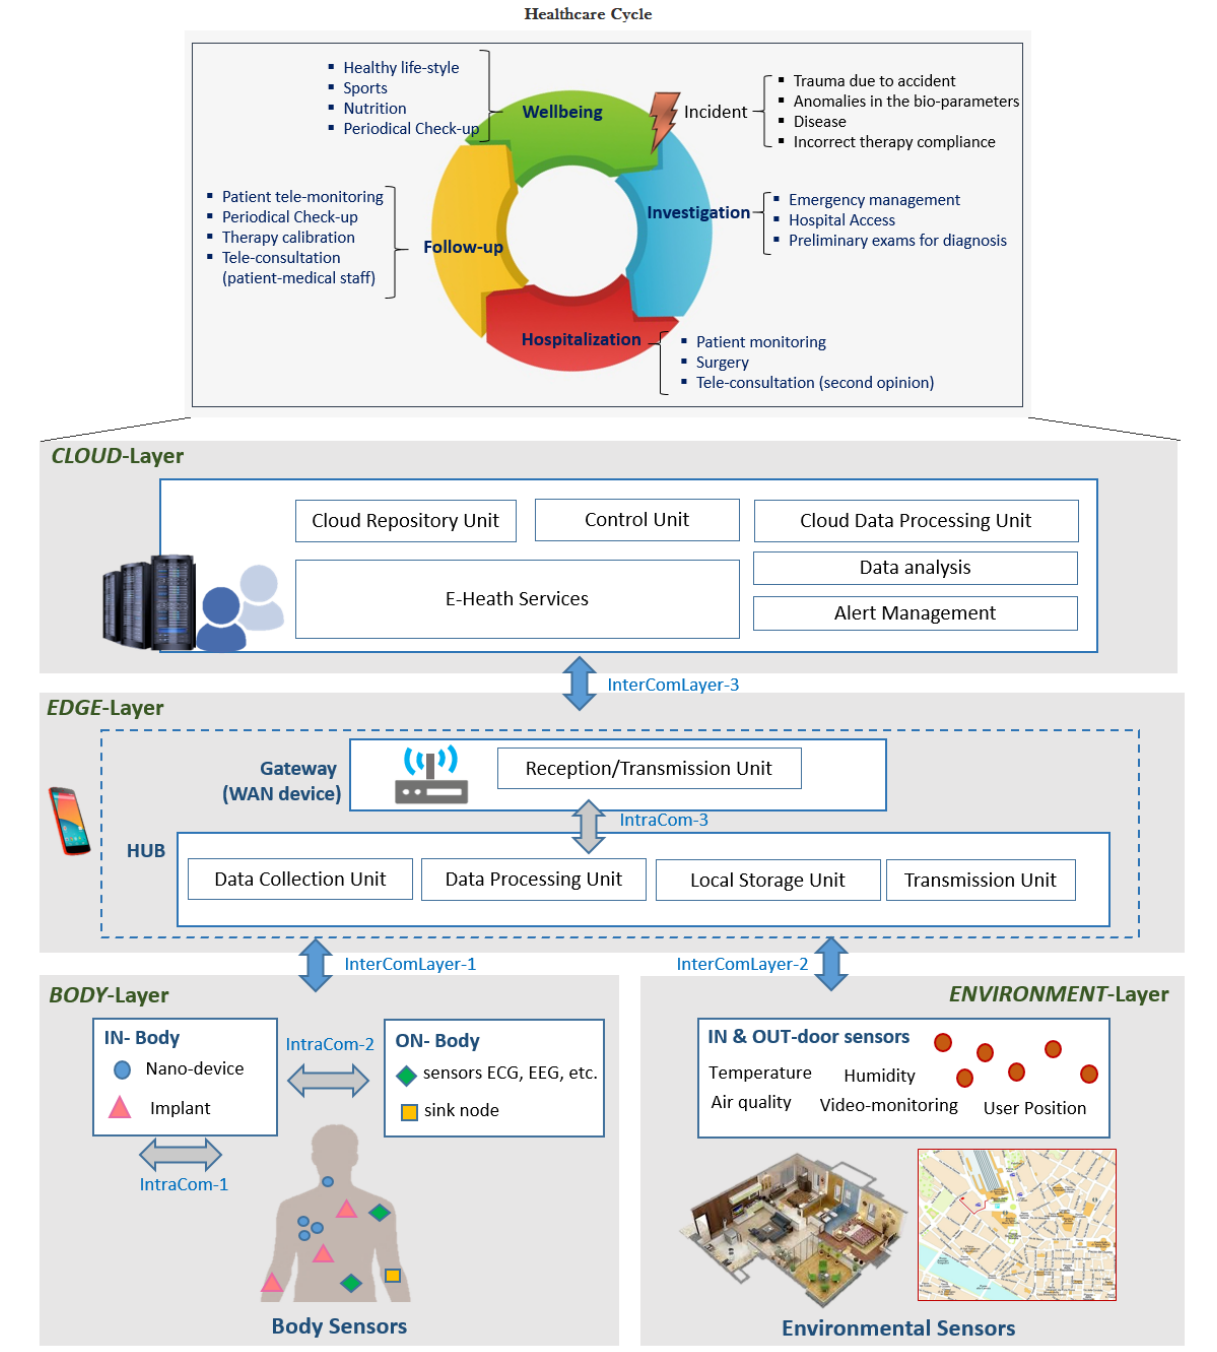
Figure 2. Healthcare Cycle and Reference Network